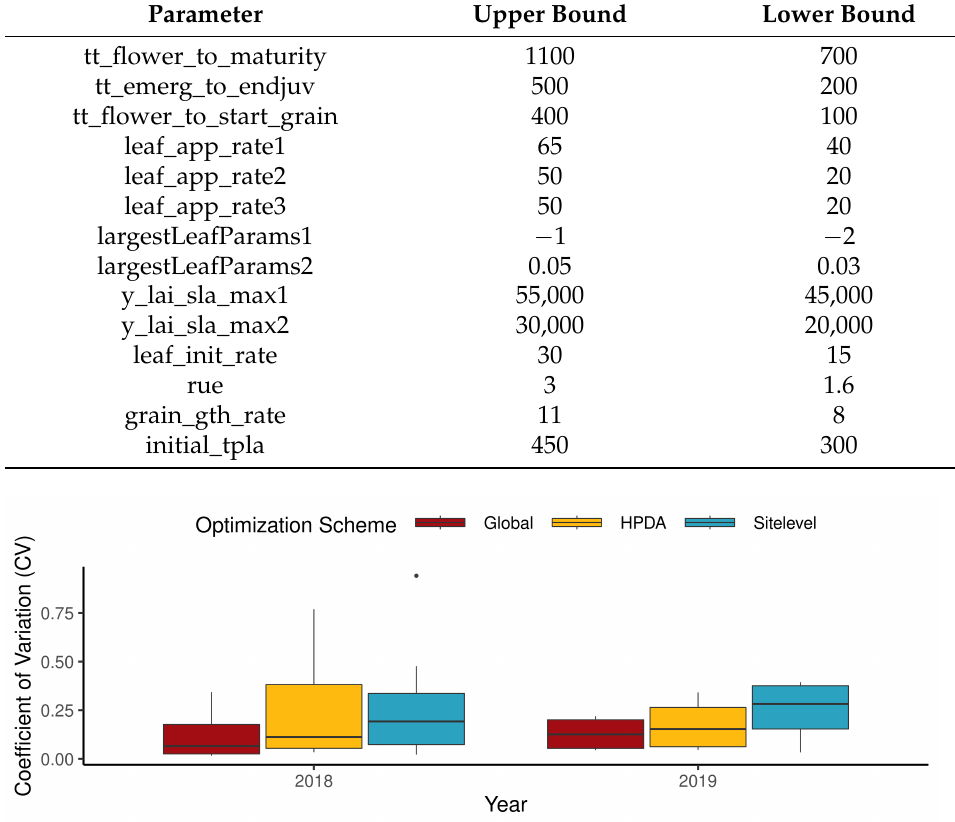
Figure A1. Within sample yield variability comparison for different optimization